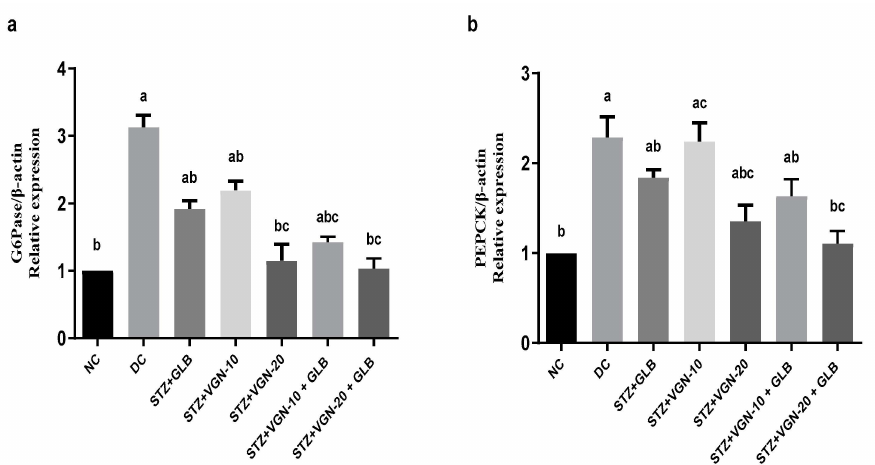
Figure 5. VGN downregulates STZ-induced PEPCK and G6Pase expression in rat liver tissues: total RNA was extracted, and mRNA expression of G6Pase ( a ) and PEPCK ( b ) was analyzed by quantitative RT-PCR. Data are expressed as fold change over basal relative to β -actin reference gene (mean ± SEM) (n = 6). a,b,c refer to significant changes at p ≤ 0.05 with respect to NC, DC and GLB groups, respectively.